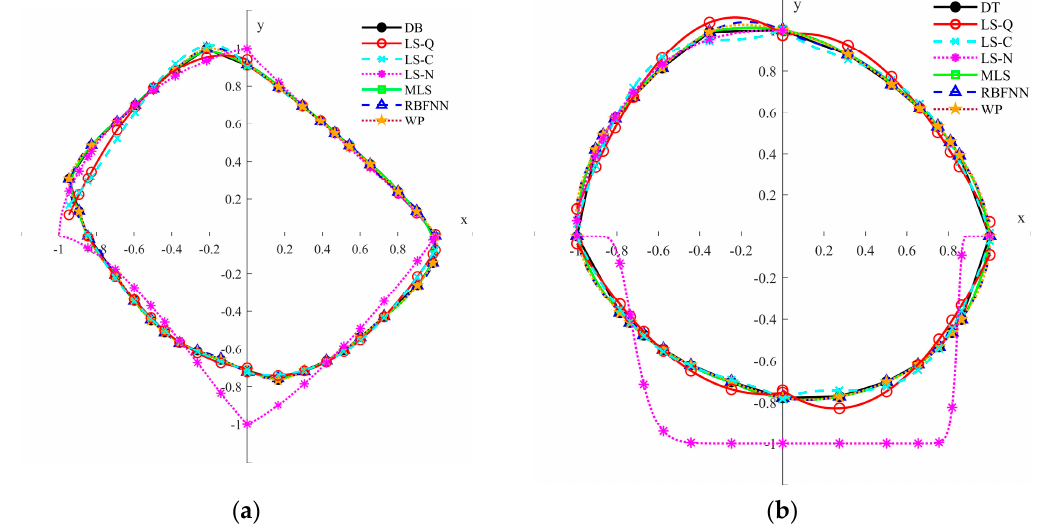
Figure 10. Fitting results for ( a ) DB and ( b ) DT.